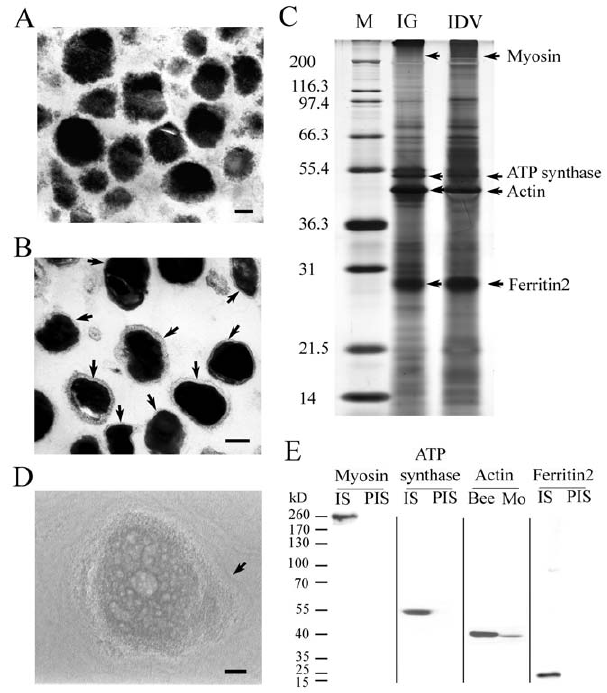
Figure 1. Purification and identification of proteins in IGs and IDVs and production of antibodies against these proteins. (A) TEM micrograph of purified IGs from trophocytes showing no enclosed vesicle membranes. Scale bar, 100 nm. (B) TEM micrograph of purified IDVs from trophocytes showing IGs in an enclosed vesicle membrane (arrows). Scale bar, 200 nm. (C) SDS-PAGE separation of SDS-soluble proteins from the purified IGs and IDVs. M, markers. IG, iron granule. IDV, iron deposition vesicle. Arrows denote the positions of major protein components (myosin, ATP synthase, actin and ferritin 2). (D) HRTEM micrograph of an IDV in a trophocyte of an adult worker bee. The gray gradient in the IDV indicates the existence of organic matrices. Arrow, the outer membrane of an IDV. Scale bar, 50 nm. (E) Western blot analysis to indicate the specificity of polyclonal antibodies against myosin (260 kD), ATP synthase (55 kD), actin (41 kD), and ferritin 2 (25 kD). IS, immune serum. PIS, pre-immune serum, Bee, total protein extract from worker bee trophocytes, Mo, total protein extract from mouse muscle.